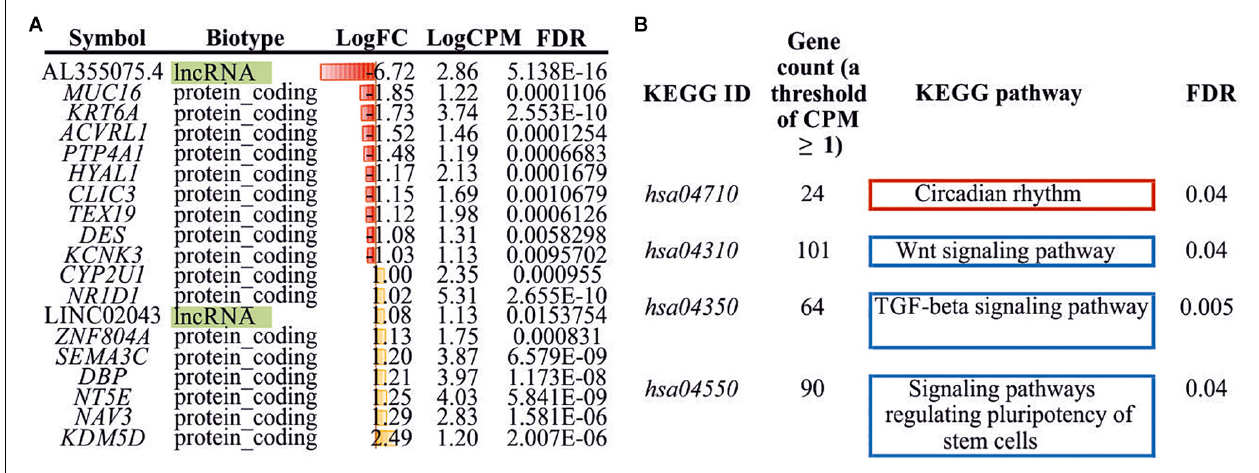
FIGURE 3 | Differently expressed genes/lncRNAs and enriched KEGG pathways. (A) DEGs/DE lncRNAs (Log2FC ≥ 1, Log2FC ≤ − 1, CPM ≥ 1, FDR < 0.05) identified between experimental and control HCT116 cells. (B) Enriched KEGG pathways (FDR < 0.05) with DEGs (CPM ≥ 1, FDR < 0.05). KEGG, Kyoto Encyclopedia of Genes and Genomes; DEG, differently expressed genes.